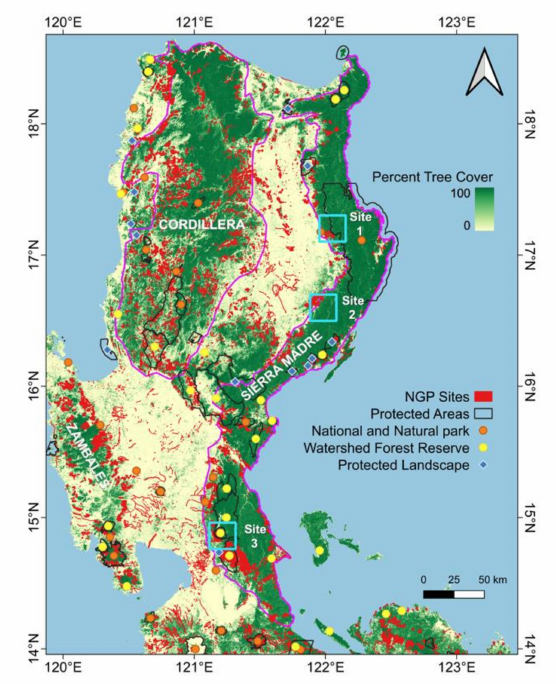
Figure 1. Satellite image of Northern Luzon showing the percentage of forest cover in the year 2000 as derived from Landsat data [14] and the locations (in red) of the National Greening Program (NGP) activities from 2011 to 2016. The three sites used in the case studies are enclosed by the square boxes (in light